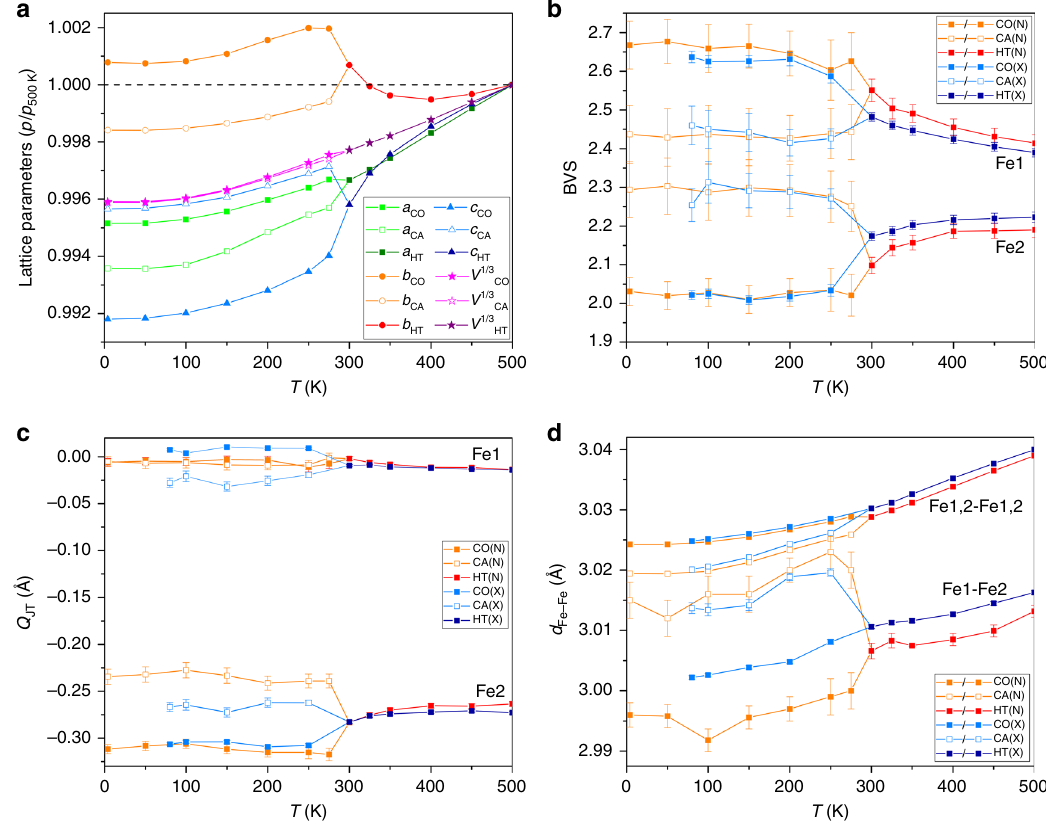
Fig. 4 Crystal structure parameters of CaFe 3 O 5 . a Changes in the lattice parameters relative to 500 K values obtained from PND ( a 500 K = 3.03896(1), b 500 = 10.01355(5) and c = 12.67039(7) Å). Temperature dependence of the b BVS and c the amplitude of Jahn – Teller distortion ( Q 500 K K octahedra for the two sites in the high temperature (HT), charge ordered (CO) and charge averaged (CA) phases, obtained from neutron (N) and synchrotron X-ray (X) diffraction data. d The evolution of the Fe1-Fe2 bonding distance with temperature, with the lattice parameter (Fe1,2-Fe1,2) as reference. Error bars are the estimated standard deviations calculated during pro fi le fi